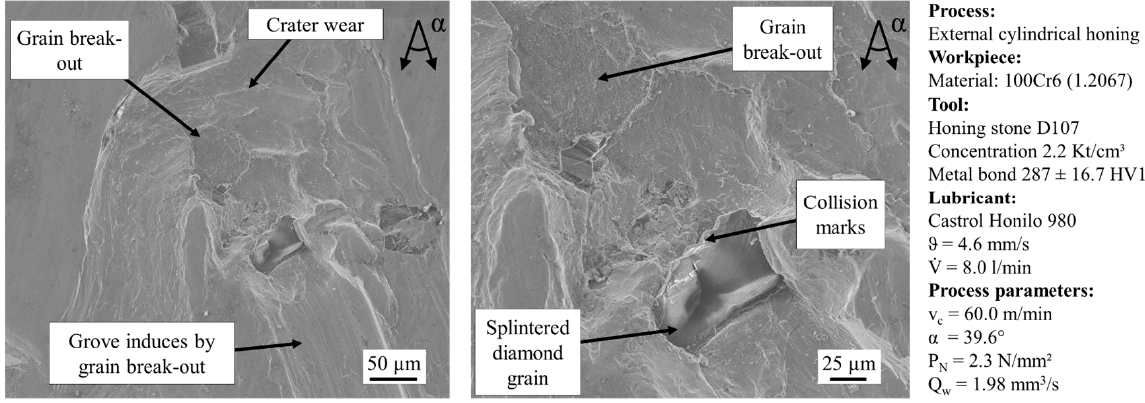
Figure 10. Distribution quality examined by computed tomography. The average number of grains per grid is x = 9.81, which is the expected value for the given speci fi cation. The dispersion of grains shows strong inequalities with a variance of σ 2 = 8.72 and a standard deviation of σ = 2.95. A general displacement of the grains to the edges or the honing stone centre was not observed. The unequal dispersion of the grains has a negative e ff ect on the cu tt ing performance and wear. This can be seen on the cross-section of the honing stone (Figure 11).